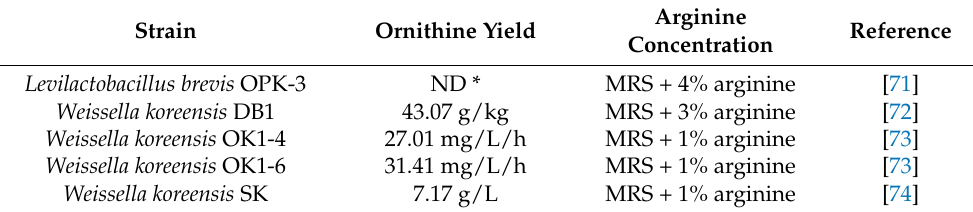
Table 4. Ornithine production yields by LAB isolated from kimchi. Strain Ornithine Yield